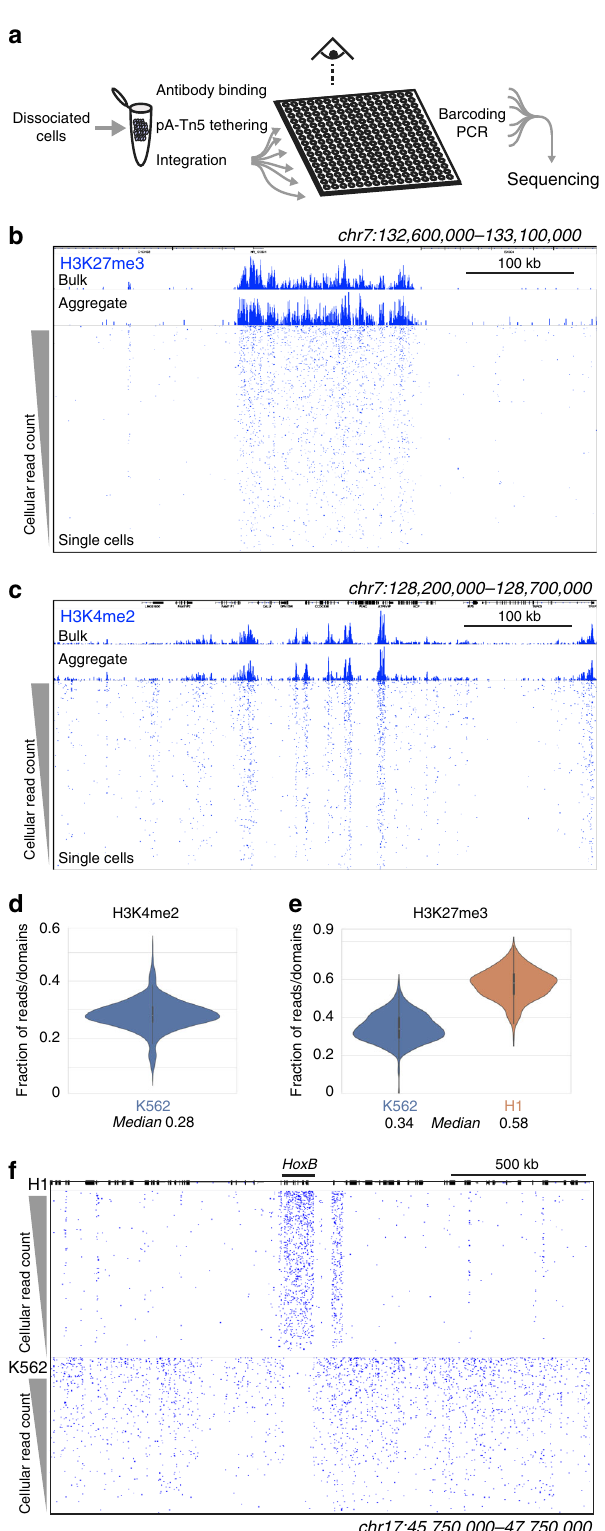
measures expressed genes, chromatin pro fi ling has the unique advantage of identifying silenced regions, which is a key aspect of establishing cell fates in development. Although methods like ATAC-seq map accessible and factor-bound sites 17 , the speci fi c chromatin proteins bound at these sites must be inferred from motif or chromatin pro fi ling data. While ChIP-based methods